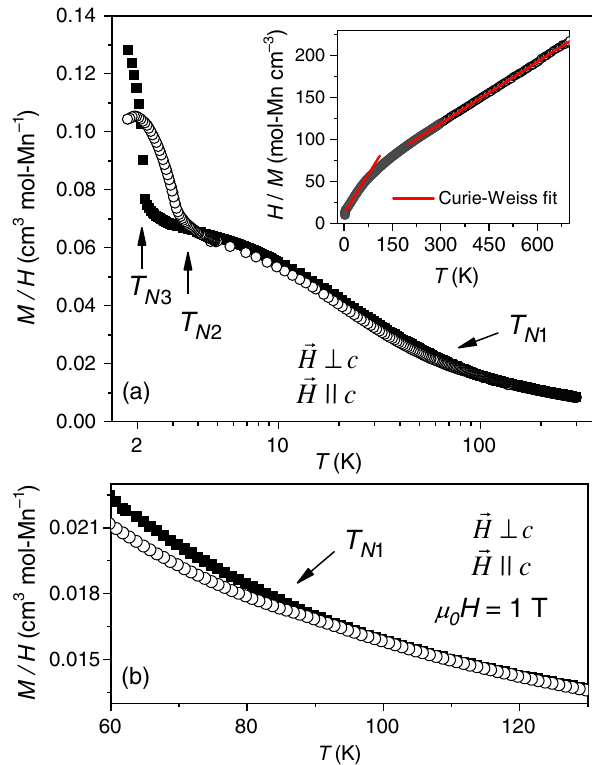
FIG. 3. (a) Evolution of the magnetic susceptibility ( M=H ) as a function of the temperature measured in a field of 1 T applied parallel (open symbol) and perpendicular (solid symbol) to the c axis. The temperature axis is given in a logarithmic scale to increase the visibility of the magnetic phase transitions. The inset shows the inverse susceptibility that features two linear regimes at 200 K < T < 700 K and 10 K < T < 50 K. The Curie-Weiss fits are shown as red lines. (b) Expanded view of magnetization curves around the T transition temperature. The magnetic order N 1 is revealed by a subtle drop in the magnetization curve measured with field applied along the c direction.